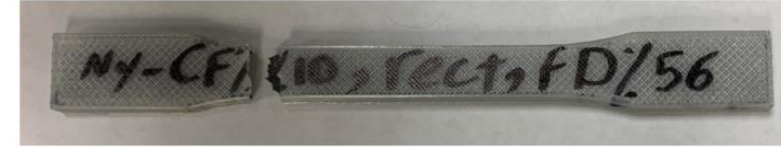
Figure 14. Fractured tensile specimen of CFRAM nylon-CF.